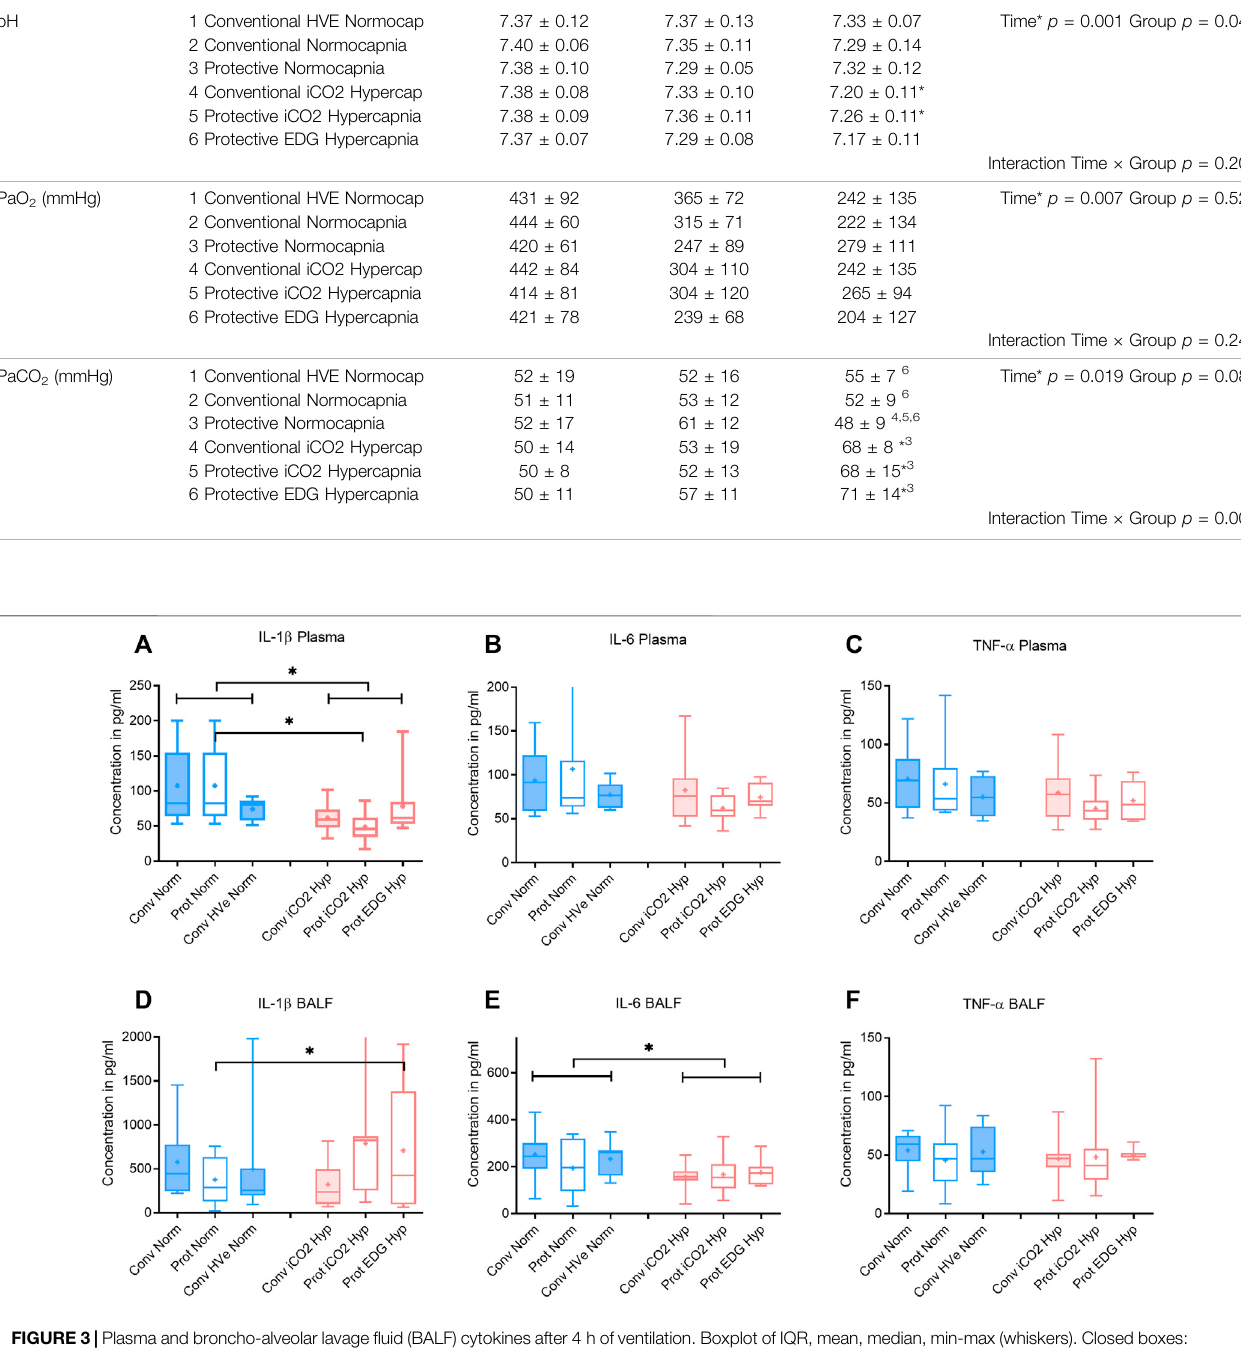
Frontiers in Physiology |